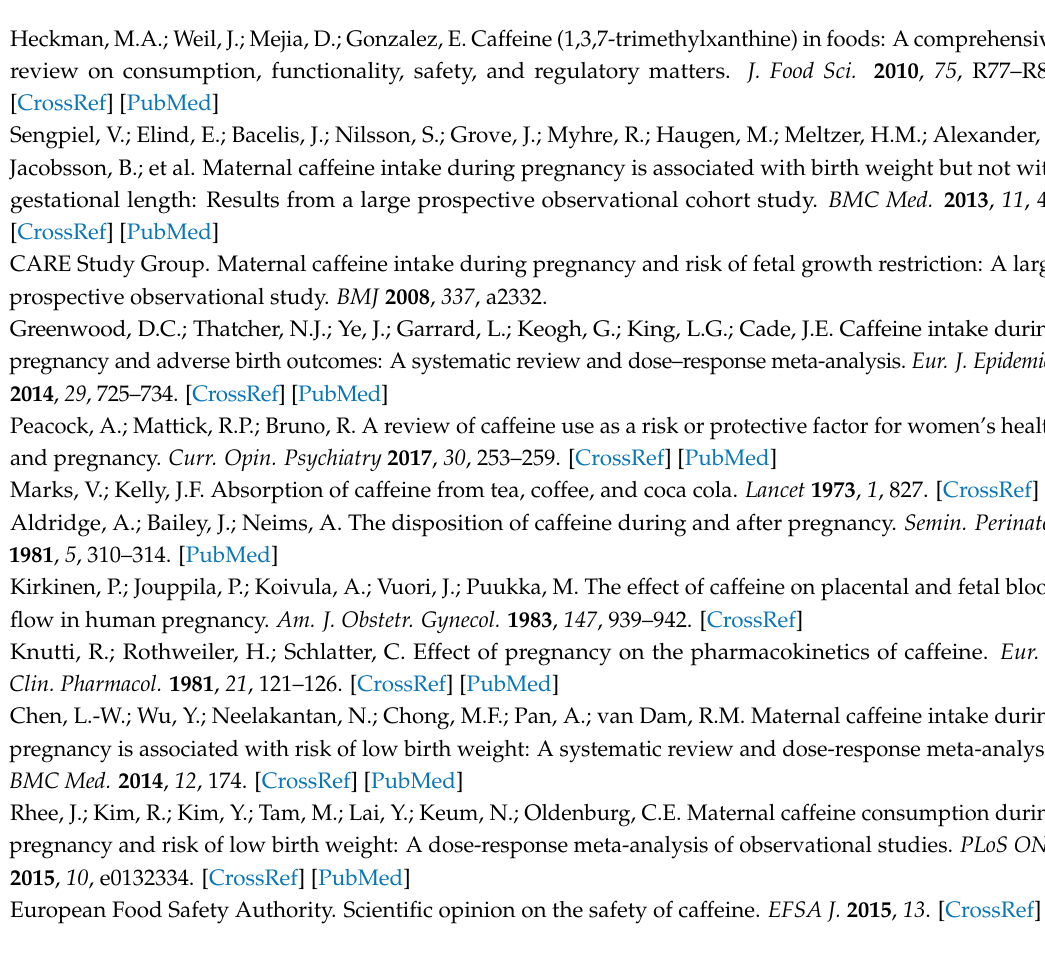
and justification, Table S2. Birth outcomes according to guideline adherence within each trimester and for each trajectory group ( n =